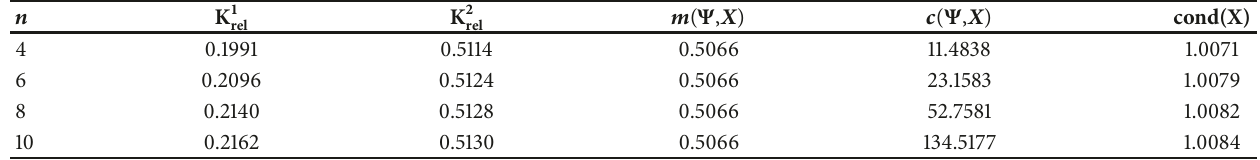
Table 1: Condition numbers for Example 1 evaluated using different tridiagonal matrices with size 𝑛 .